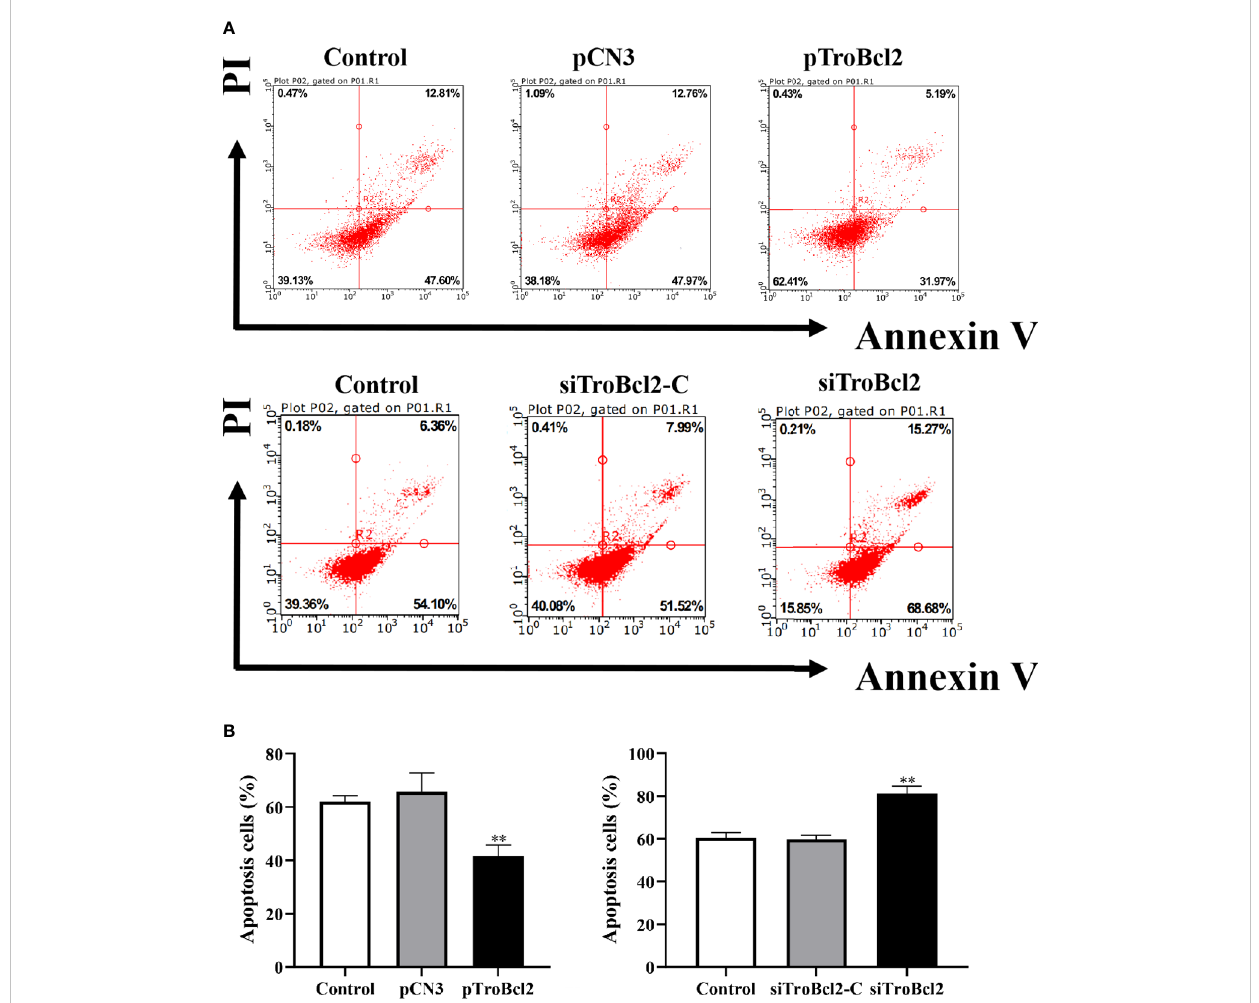
FIGURE 4 Effects of TroBcl2 overexpression and knockdown on cell apoptosis upon LPS stimulation. GPS cells transfected with pTroBcl2 or pCN3 were treated with LPS and the cell apoptosis was evaluated by fl ow cytometry (A-1) , and the bar chart represents the percentage of apoptotic cells (B-1) . Non- transfected cells treated with LPS were as the control. GPS cells transfected with siTroBcl2 or siTroBcl2-C were treated with LPS and the cell apoptosis was evaluated by fl ow cytometry (A-2) , and the bar chart represents the percentage of apoptotic cells (B-2) . Non-transfected cells treated with LPS were as the control. Data in (A) are one representative of three independent experiments, and (B) are presented as means ± SD (N = 3). N, experimental number. ** P <